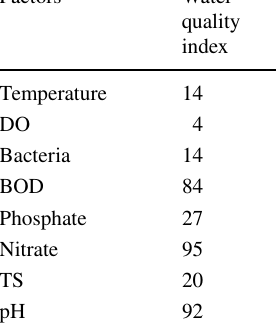
Table 7 General water quality